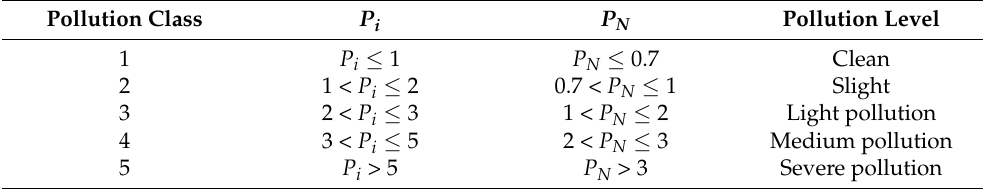
Table 2. Nemerow comprehensive pollution index classification table.